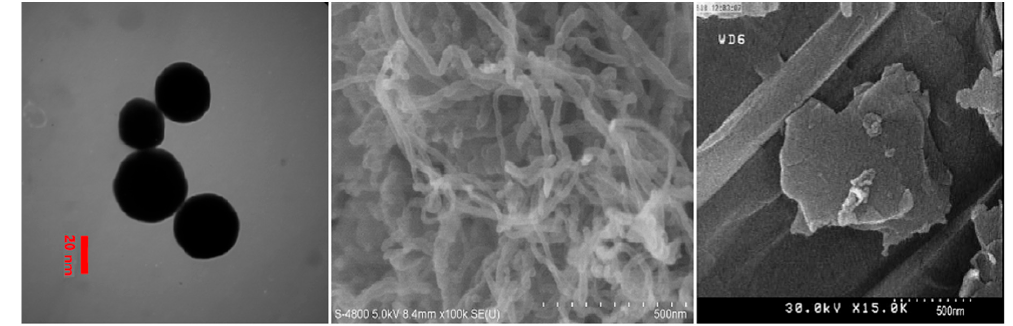
Figure 2. Microscopic images of nanoparticles Al 2 O 3 , multiwall carbon nanotube (MWCNT), and graphite (left to right).